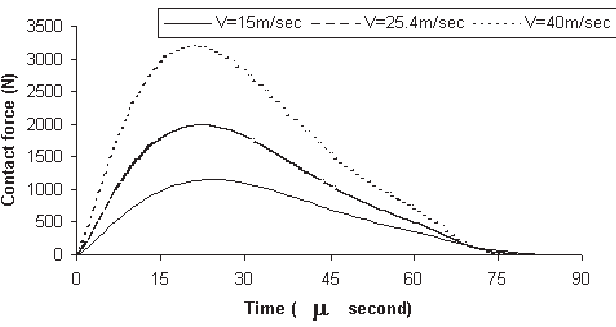
Fig. 13. Variation of adaptive contact force (point contact) on composite plate with respect to time for different impact velocity but fixed Mi/Mp.